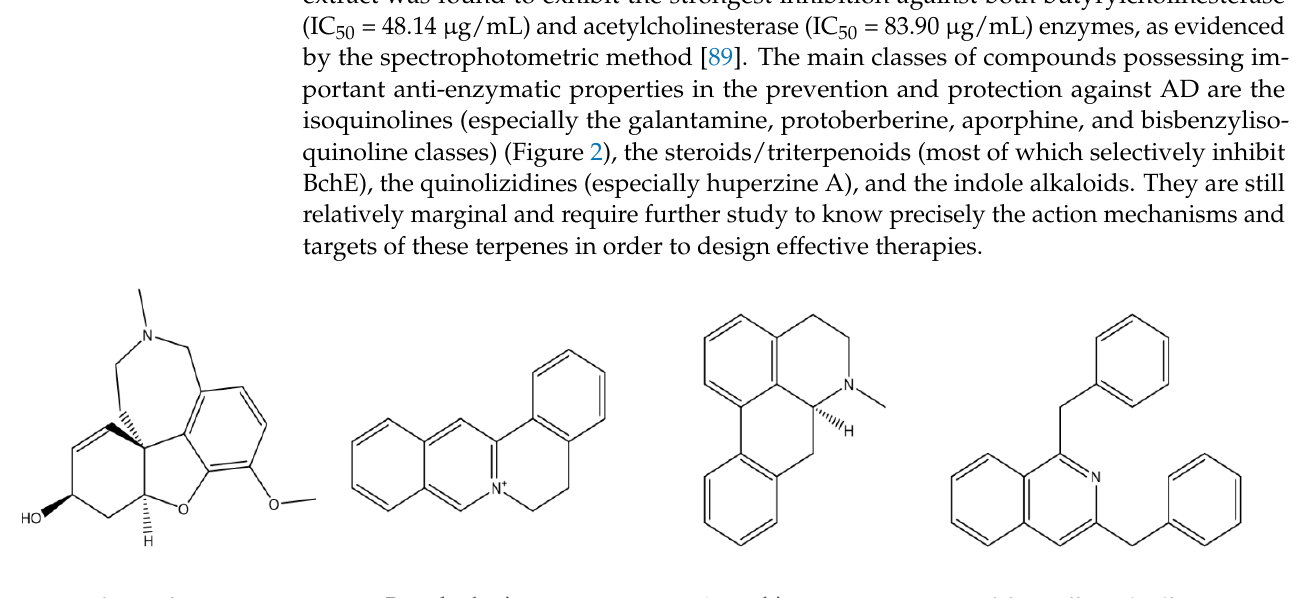
Figure 1. Structures of alkaloids with anti-Alzheimer effects.